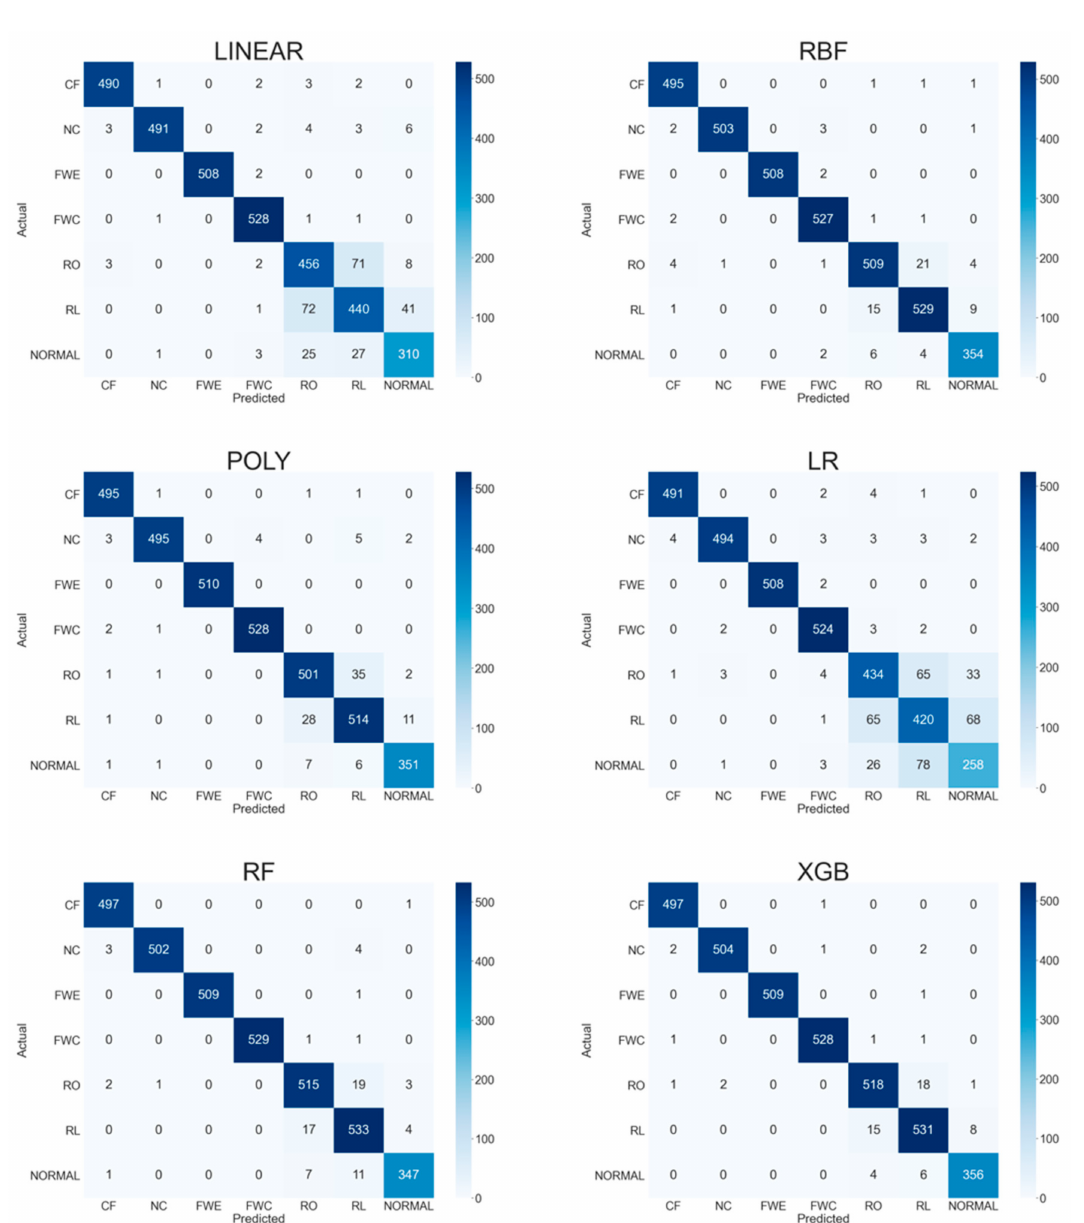
Figure 18. Confusion matrices for parameter-tuned classification methods (Case